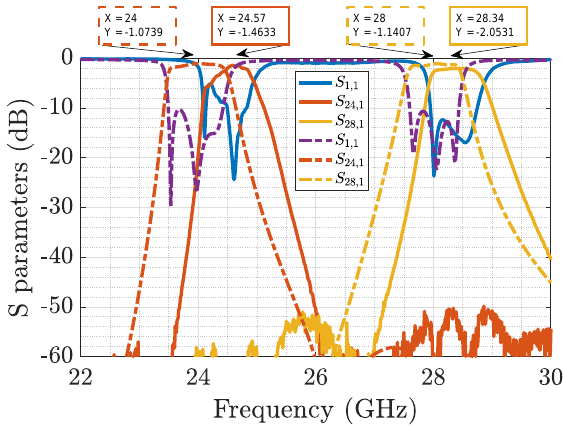
( a ) Parts breakdown of diplexer. ( b ) Top of assembled diplexer with transition and connectors. Figure 11. Diplexer mounting and assembly.